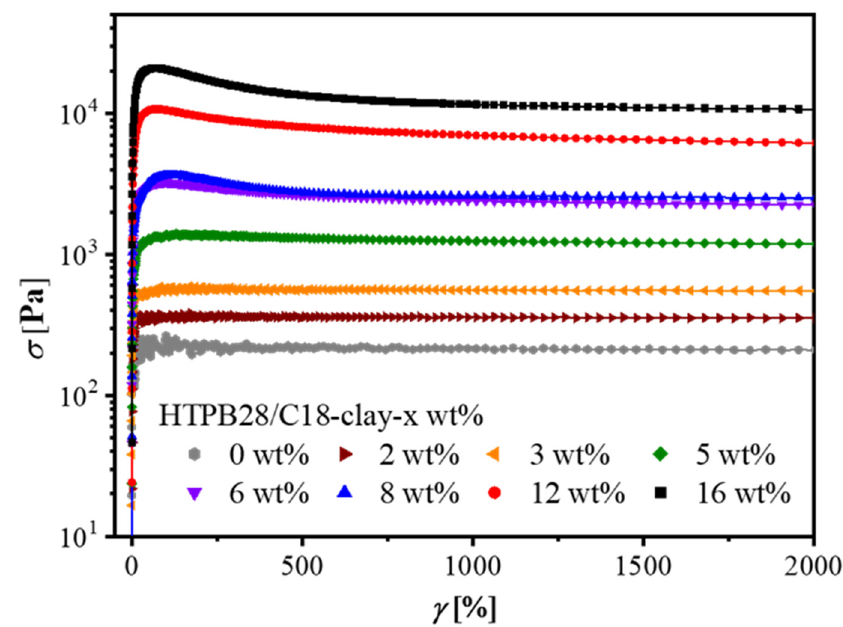
Figure 4. Concentration dependence of HTPB28/C18-clay at a startup shear at 20 °C. A shear rate of 10 s − 1 is big enough to break the network structure.